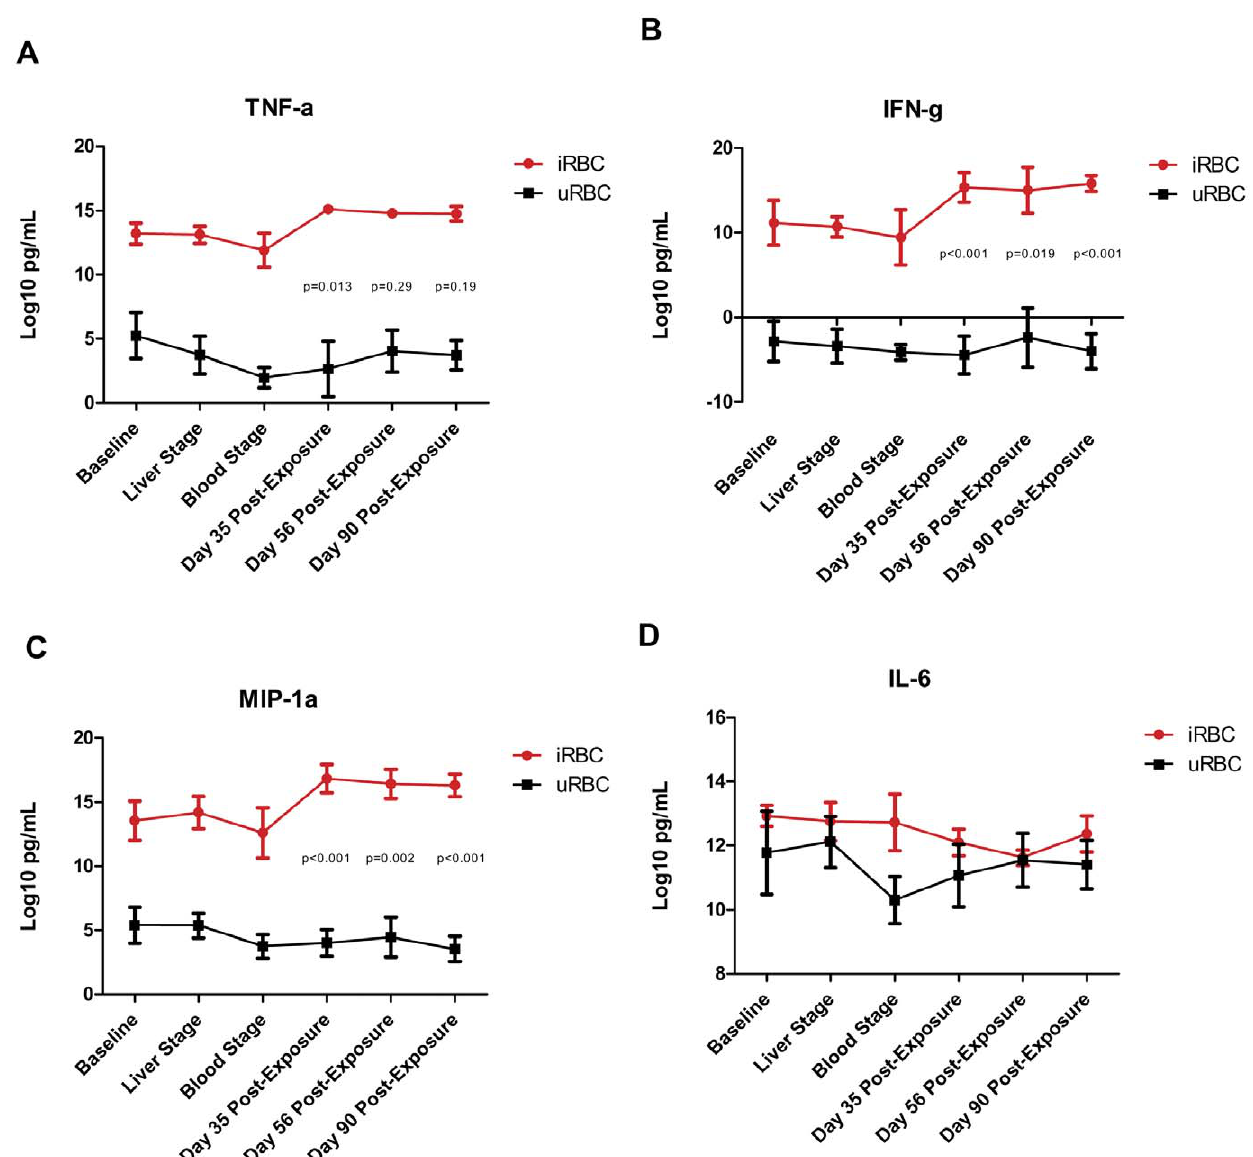
Figure 2. Plasmodiumfalciparum stimulates enhanced secretion of TNF- a , IFN- c , and MIP-1 a , but not IL-6. PBMCs from the malaria challenge trial participants were infected with HIV and co-cultured with iRBC and uRBC at the 6 visits as described earlier. Cytokine secretion in the iRBC (red lines) and uRBC (black lines) co-culture supernatants was measured using the BioPlex platform. Cytokine production was measured at days 1, 4, 6, and 8 post initiation of co-culture and the area under the curve was calculated for each participant at each visit and plotted in A – D as the average for the 5 participants, error bars represent the 95% CI. Repeated measures ANOVA was used to determine significance in the difference in amount of cytokines secreted (iRBC-uRBC) at the post-exposure time points compared to the difference in amount of cytokine secreted (iRBC-uRBC) at baseline. p-values have been corrected for multiple comparisons: TNF- a day 35 p=0.013, day 56 p=0.29, day 90 p=0.19; IFN- c day 35 p , 0.001, day 56 p=0.019, day 90 p , 0.001; MIP-1 a day 35 p , 0.001, day 56 p=0.002, day 90 p , 0.001. There was an increase in TNF- a , IFN- c , and MIP-1 a (A– C) secretion in the iRBC co-cultures compared to the uRBC co-cultures at all time points and an enhanced secretion at the convalescent time points. There was no difference in IL-6 secretion